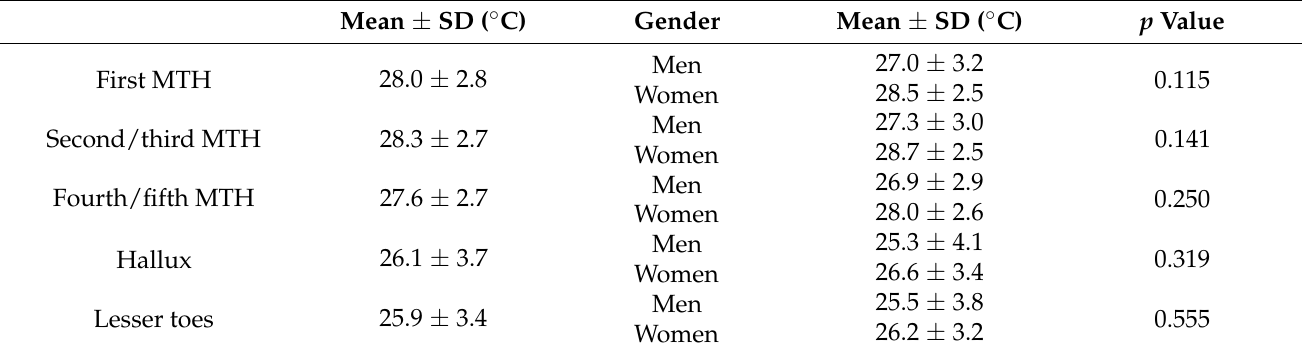
Table 1. Initial temperatures in all zones, and differences by sex.